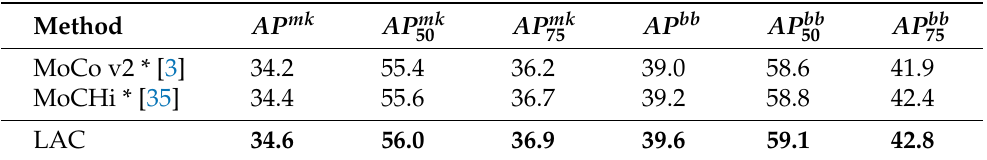
Table 3. Instance segmentation and object detection results on COCO with the ×1 training schedule and a C4 backbone. * denotes reproduced results. AP mk means mask average precision. AP bb means the bounding-box average precision ( AP bb ). AP ∗ is the average over 10 IoU levels on 80 categories (start from 0.5 to 0.95 with a step size of 0.05). AP ∗ AP with IoU = 0.75. The best results are in